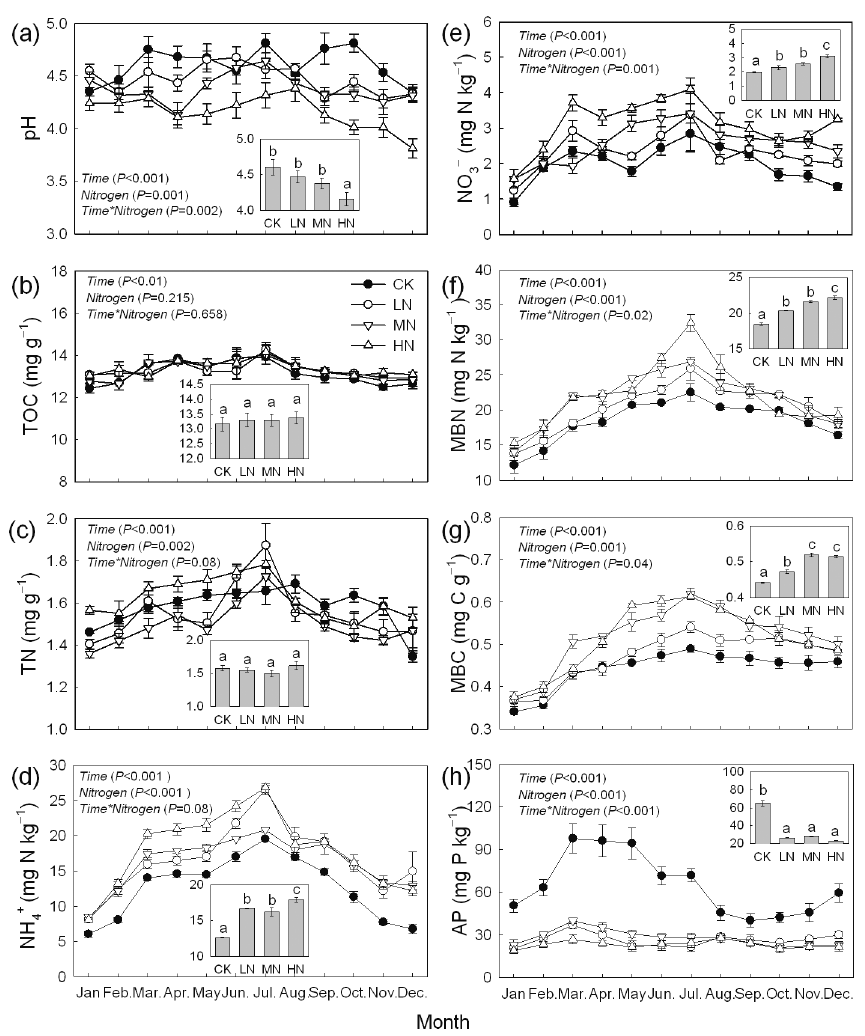
Figure 3. Seasonal variations of soil properties in a Bambusapervariabilis 6 Dendrocalamopsisdaii plantation from January to December 2009 (mean ± SE, n =3). TOC: total organic carbon; TN: total nitrogen; MBN: microbial biomass nitrogen; MBC: microbial biomass carbon; AP: available phosphorus. Average values of yearly measures were exhibited in the histograms (mean 6 SE, n =3). Results of repeated measures ANOVAs are shown in text. Different letters indicate significant difference among N addition treatments when nitrogen effect is significant ( P , 0.05, Fisher’s least significant difference test). CK, LN, MN and HN are as in Fig. 2.